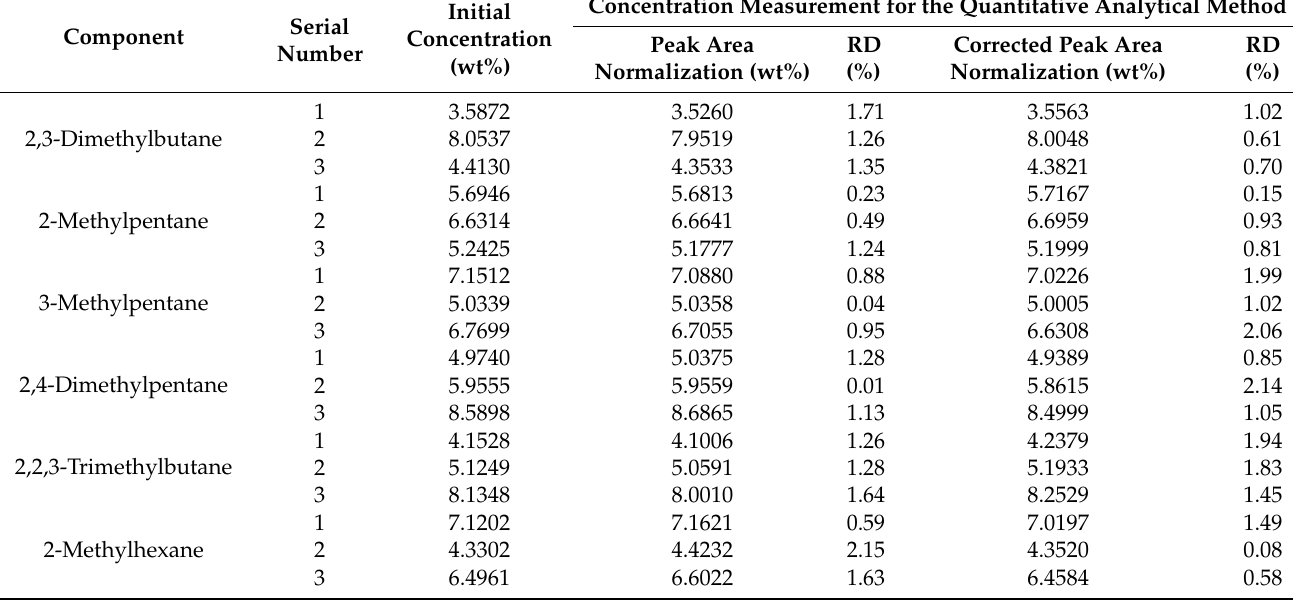
Table 2. Comparison of the quantitative analysis results of the peak area normalization method and the corrected peak area normalization